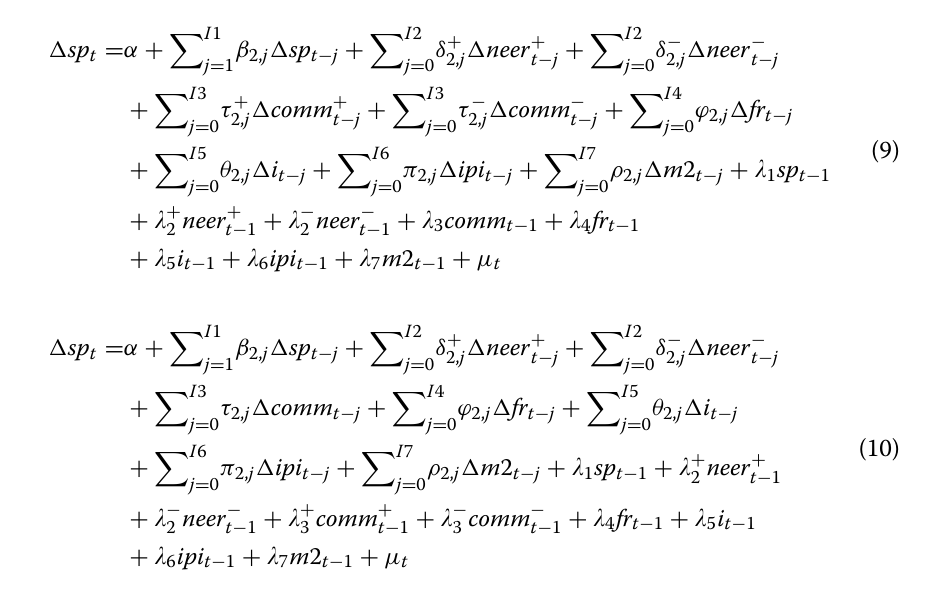
(1) The test equation includes both trend and intercept, and the optimal lags are determined using the Schwarz information criterion. The maximum lags are 8. (2) The p-values of the ADF and PP tests adopt MacKinnon’s (1996) one-sided p-values. (3) ***, ** and * denote significance at the 1%, 5% and 10% levels, respectively. (3) The null hypothesis of both the ADF and PP tests are that the series have a unit root. If the null hypothesis is rejected, we can conclude that the series is